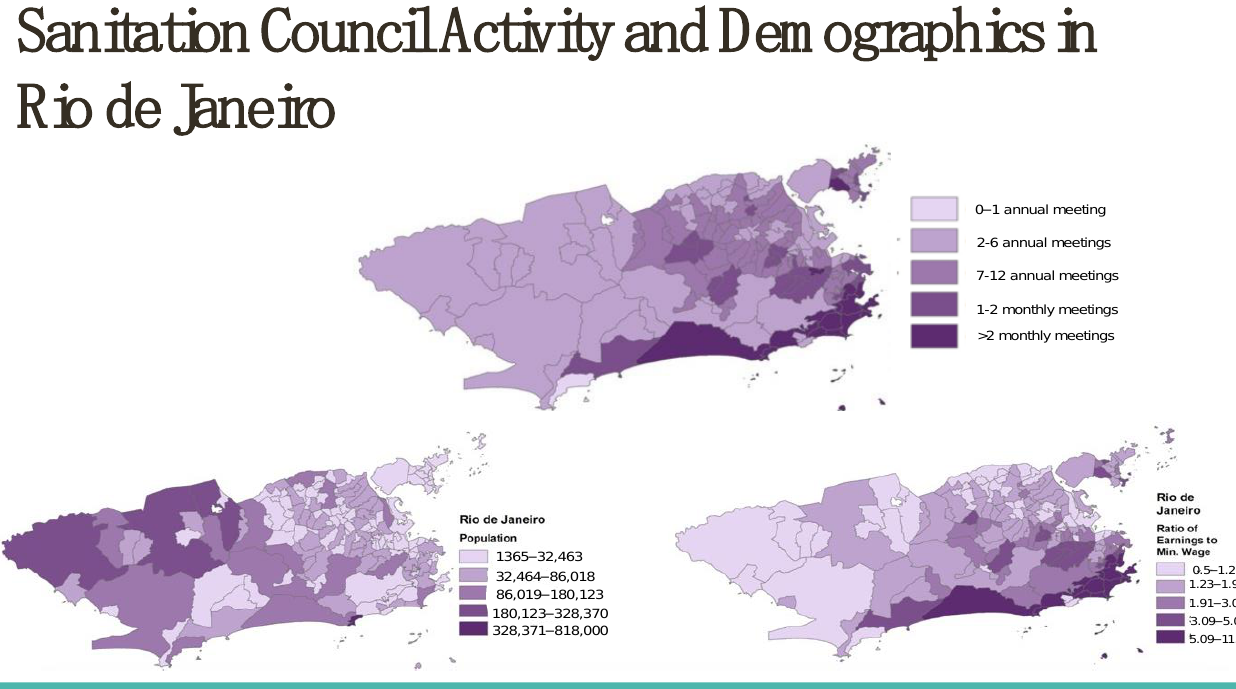
Table 1. This table reports the results of negative binomial estimation following pre-processing through Coarsened Exact Matching. Municipal Zika Cases per 100,000 Residents Predictors